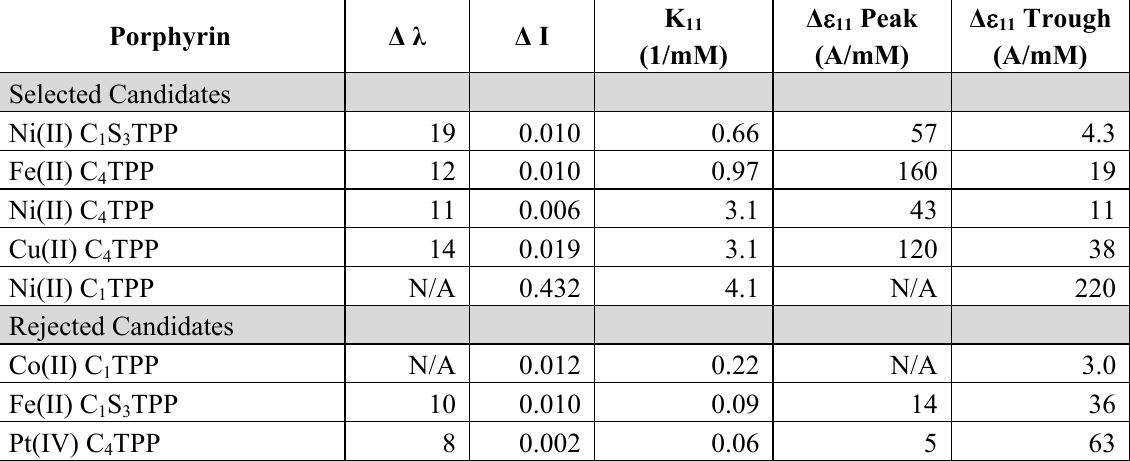
Table 1 . Interaction of porphyrins with paraoxon in solution.